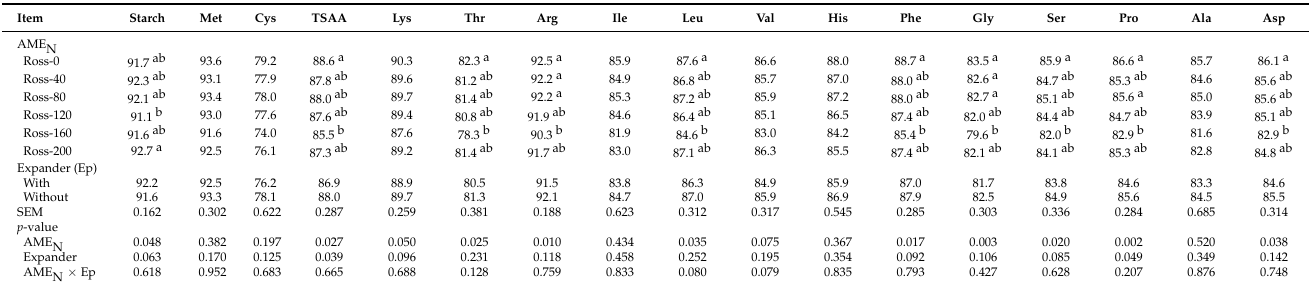
Table 8. Broiler apparent ileal digestibility of starch and amino acids,